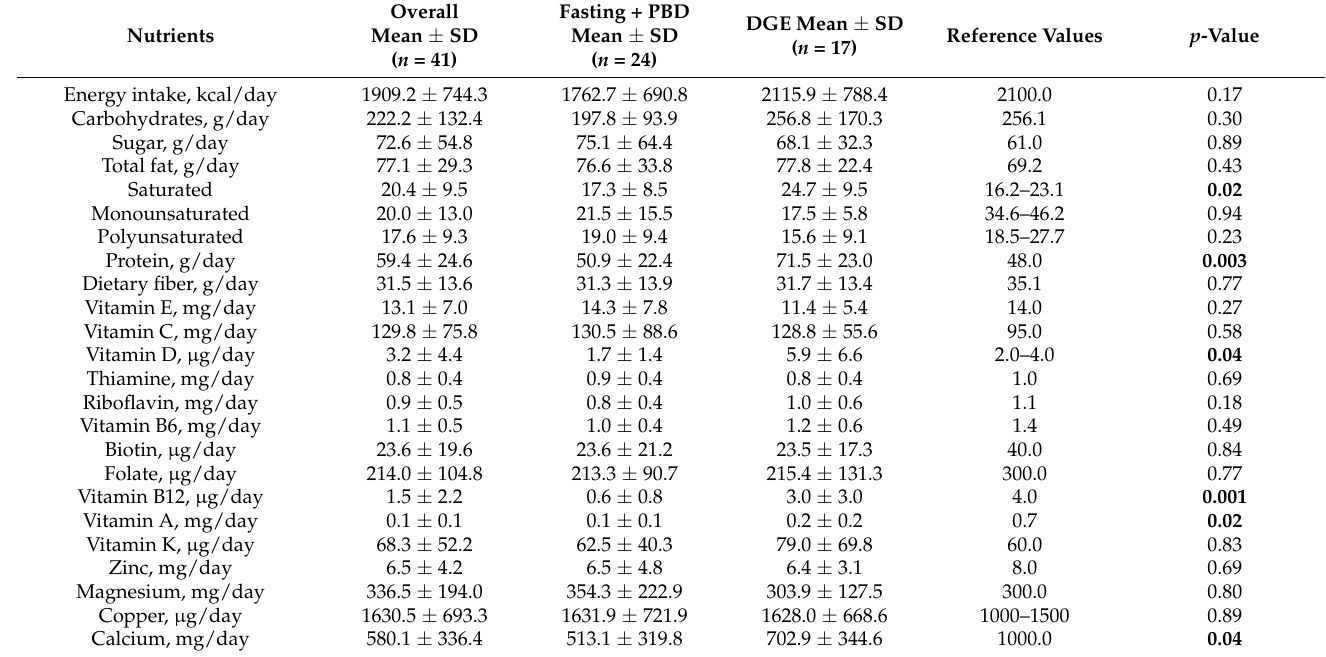
Table 2. Nutrient supply of participants with RA at study week 4 as well as the DGE reference values for adult women [22].